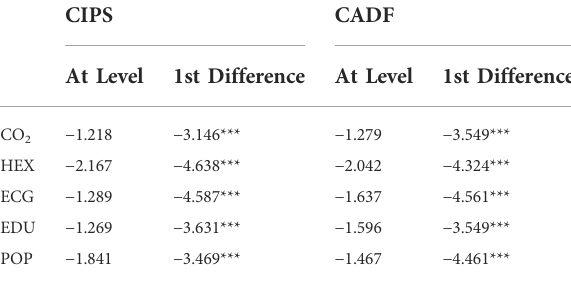
TABLE 4 The (Pesaran, 2007) Panel Unit-root